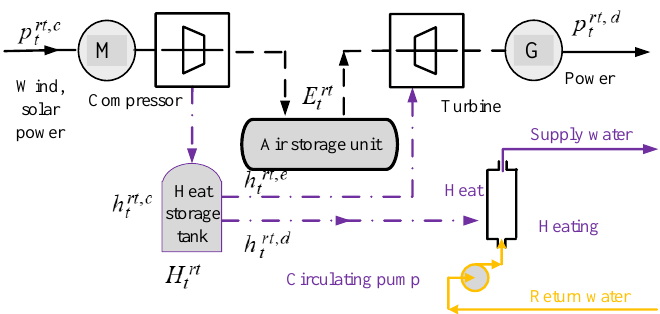
Figure 1. Illustration of energy